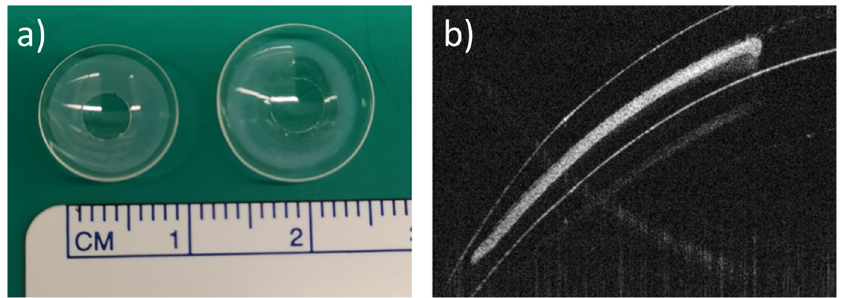
Figure 1. Miltefosine-eluting contact lens (MLF-CL). ( a ) Photographs of dry (left) and hydrated (right) contact lens. ( b ) An ocular coherence tomography (OCT) image of a section of a dry MLF-CL